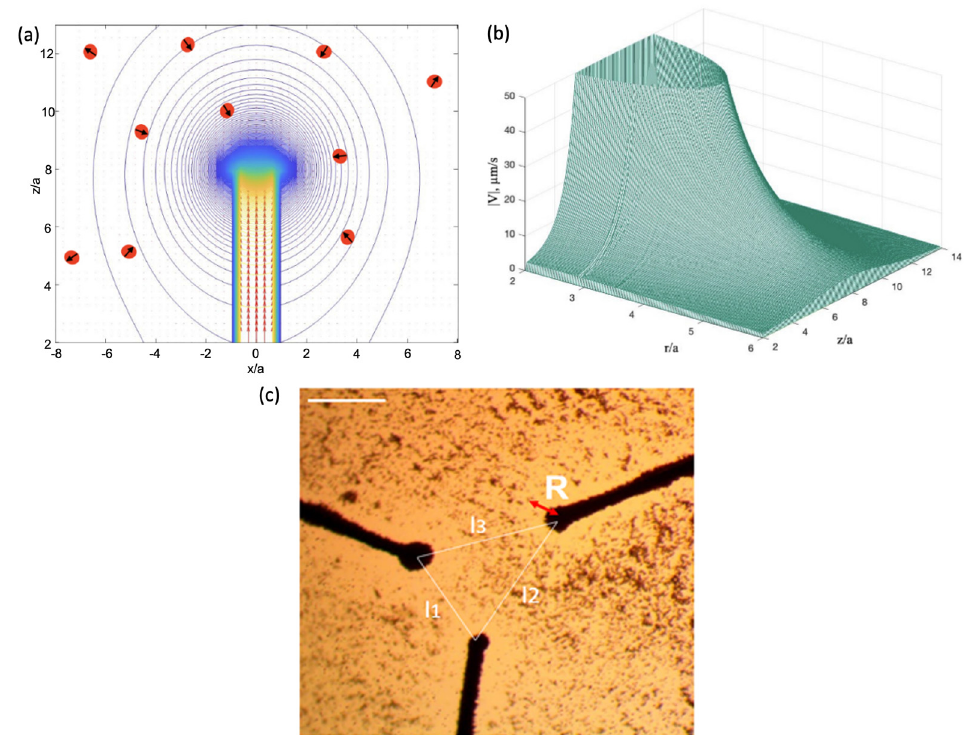
Figure 5. ( a ) Schematic illustration of the paramagnetic particle capture and acceleration towards the wire. ( b ) Particle velocity as it moves towards the wire. For calculations, the field distribution in Figure 2 was used. As particles, cells (human hepatocellular carcinoma line (Huh7)) with internalised iron oxide NPs were considered [28]: R h = 5 µ m, and the mass of magnetic NPs in the cell is 1 pg with the total volume of 0.2 µ m 3 . Taking χ = 10 4 for a magnetic nanoparticle, the effective susceptibility of a cell is 2. η = 8.9 · 10 − 4 Pa × s (viscosity of water). ( c ) Distribution of iron oxide NPs around amorphous microwires of Co-based alloy with a diameter of 30 microns after the application of a small magnetic field that magnetises the wires along the axis. Areas around microwire edges are free from particles. Arrow R designates the size of particle-free area. Scale bar equals 200 μ m. Figure ( c ) is reprinted with permission from ref. [28]. Copyright 2020, Elsevier B.V.